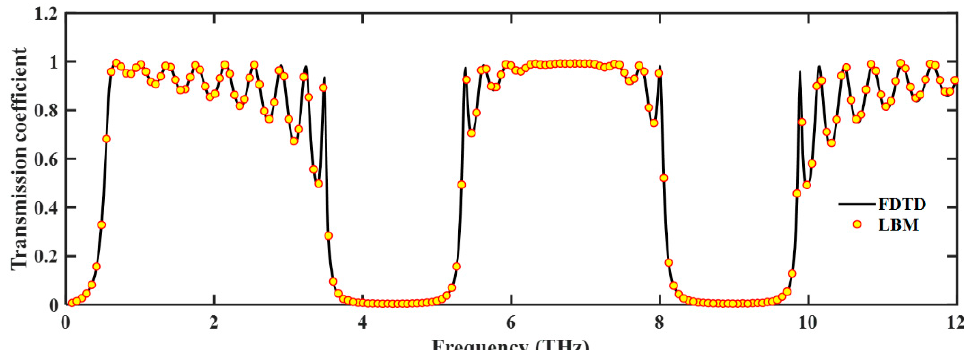
Figure 4. Comparison of the transmission coefficient in magnitude and PBGs, plotted as a function of frequency. There are two significant PBGs in the frequency domain region of 2.0–10.0 THz. The black solid curve is based on the FDTD method, and the curve with circular markers is based on our proposed method.